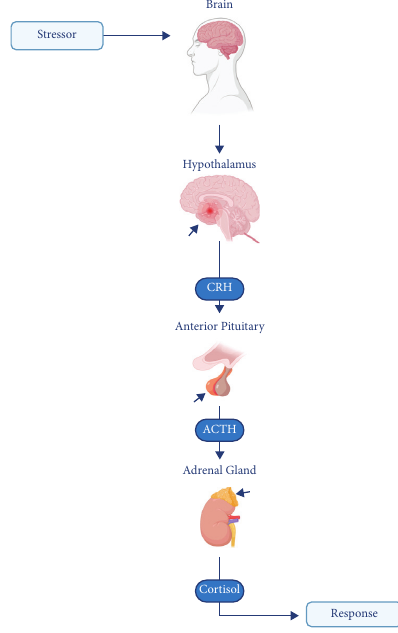
Figure 1: The cortisol pathway [6]. CRH: corticotropin-releasing hormone and ACTH: adrenocorticotropic hormone (created with